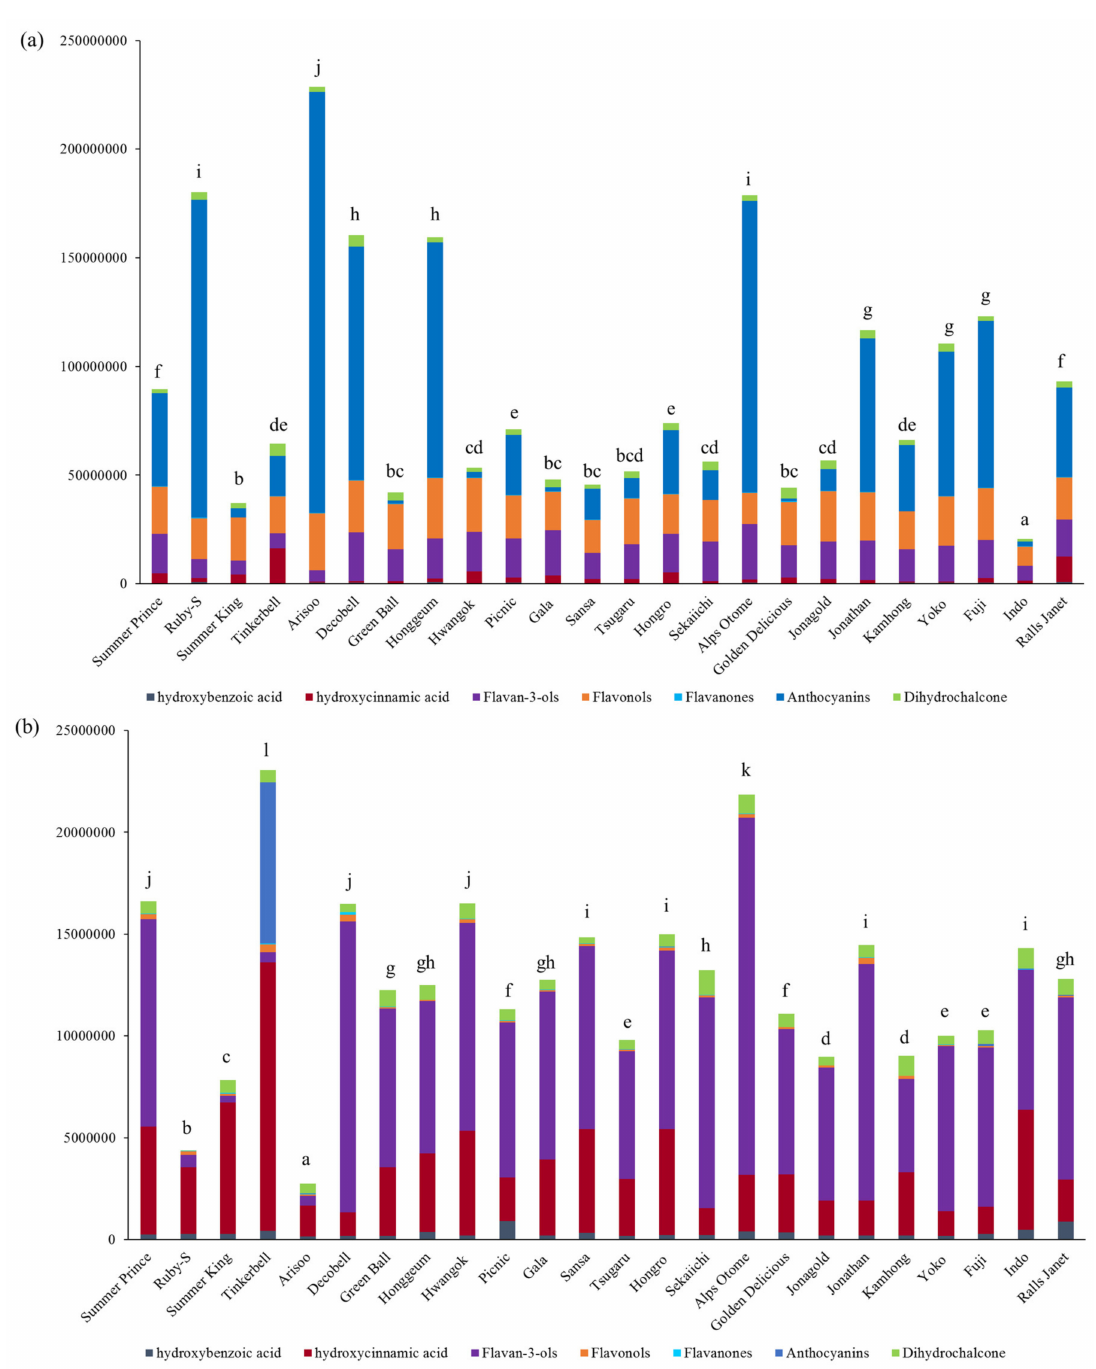
Figure 3. Average extracted ion chromatogram (EIC) peak areas of the identified phenolic compounds obtained from MS1 data of UHPLC-(ESI)-qTOF in ( a ) peel and ( b ) pulp of apple samples. Significant di ff erences between cultivars at p < 0.05 are denoted by di ff erent letters. 3.5. Quantification of Phenolic Compounds in the Apple Peel and Pulp by